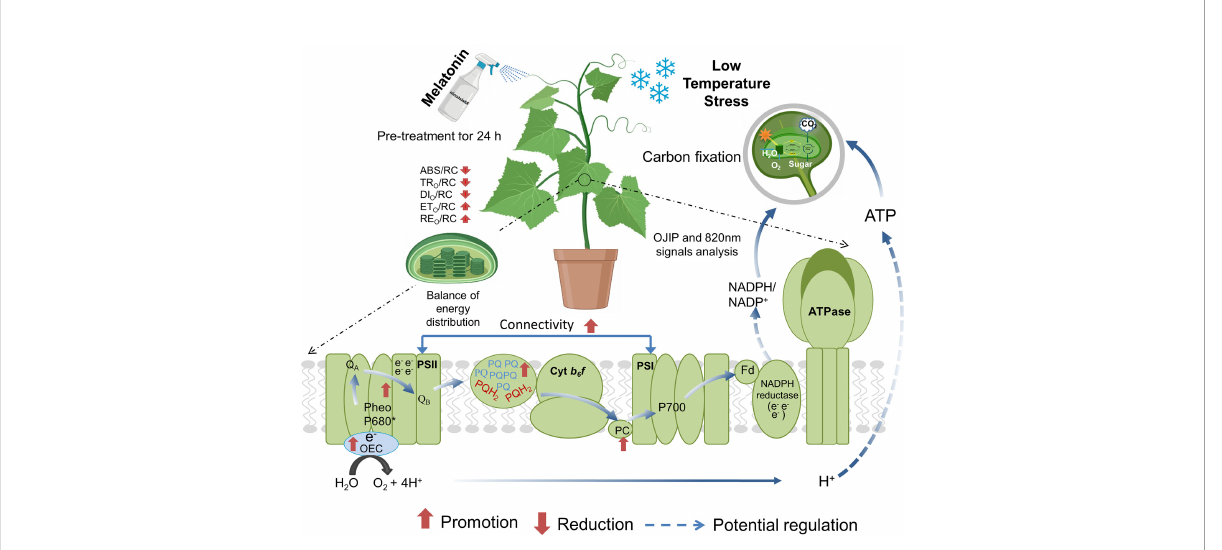
FIGURE 10 A hypothetical model showing melatonin (MT)-induced regulation of photosynthesis and photosystem performance under low temperature stress in cucumber. MT could improve light reactions and electron transport from PSII via Q A to PC + and P700 + in the photosystem by strengthening the connectivity between PSI and PSII. MT also improved the OCE activity, resulting in an increase in the photochemical decomposition of water and more H + drives ATP synthesis via ATP synthase. In addition, MT increased the PSI activity, deoxidation rates of PC + and P700 + and decreased the oxidation rate of PC and P700 and further increased the electron transport. QA, primary quinone electron acceptor; PSII, photosystem II; PSI, photosystem I; OCE, oxygen evolving complex; PC, plastocyanin; P700, PSI reaction